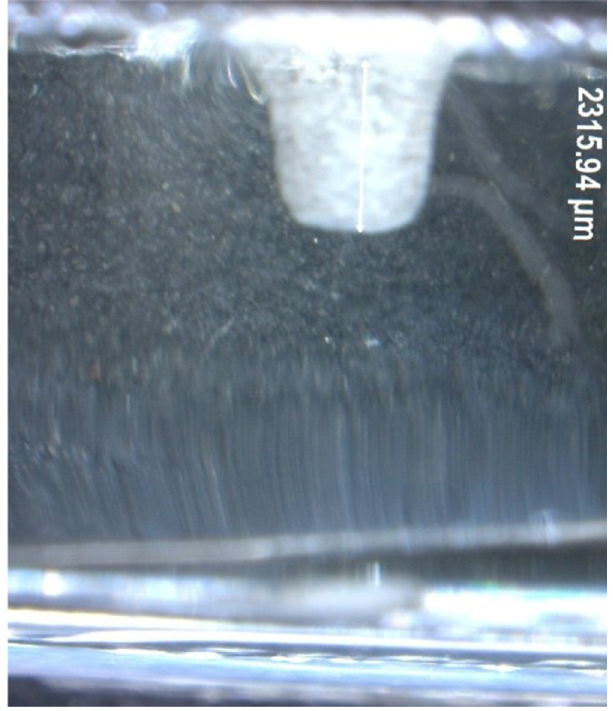
Fig. 6. Side view of micro hole machined at 37 V, 25% with Al 2 O 3